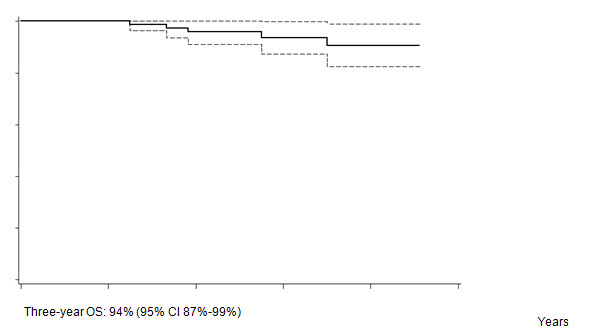
Overall survival (OS).